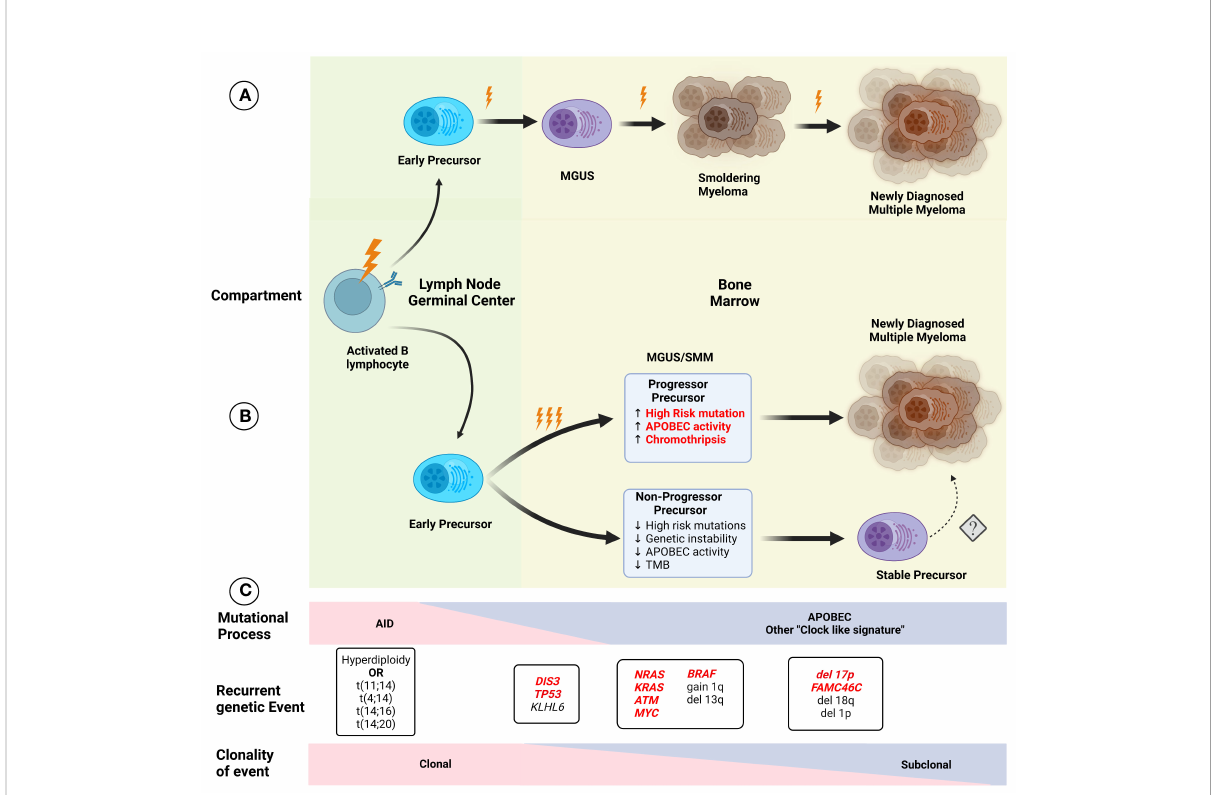
FIGURE 2 Initial models of (A) myelomagenesis postulated the appearance of a precursor clone which required acquisition of mutations and/or chromosomal abnormalities in a stepwise fashion leading to the observe progression from monoclonal gammopathy of uncertain signi fi cance (MGUS), to smoldering myeloma (SMM) and fi nally multiple myeloma (MM) after enough pathogenic event have occurred. (B) Based on recent fi ndings, the paradigm of myelomagenesis has shifted, with highly clonal events, such as recurrent translocations involving IGH gene and hyperdiploidy representing fundational events. The role of AID initially, and later APOBEC as important mutational process likely contribute to acquisition of additional events (and possibly several during one event, described as “ catastrophic evolution ” ). At the moment of clinically evident precursors (MGUS/SMM), two groups of are present, one characterized by higher genomic instability, with higher tumor mutation burden (TMB), increased chromoplexis and other complex structural events, and increased in pathogenic events, whereas the “ non-progressor ” precursor have low risk of progression over time and lack some of the features described before, although the potential risk of conversion to a more aggressive disease with progression to MM is not clear (denoted by dashed arrow). Several characteristics in the precursor clone (highlighted in red) indicate a higher risk of progression and potentially could be used clinically for risk strati fi cation. (C) The effect of different mutational process potentially varies over time, with an increased in AID, while APOBEC and other process such as “ clock-like ” signatures are present at a later time. Except for early foundational events described before, other alterations display different degrees of sub clonality, with most cases of MM exhibiting relatively preserved clonal structure upon